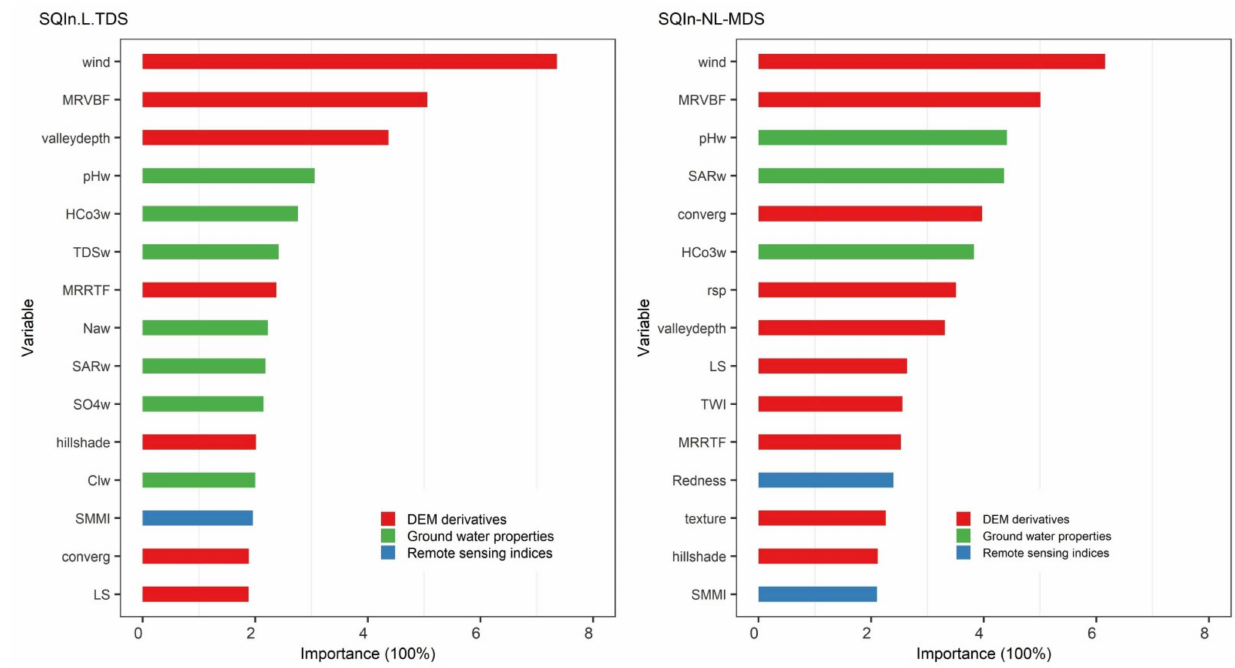
Figure 7. Analysis of the relative importance of covariates studied for soil quality (SQ) modeling using random forest (RF) for the best performance soil quality indicator ( SQI ) maps, including SQI n-L-TDS and SQI n-NL-MDS . Symbols for covariates are given in Table